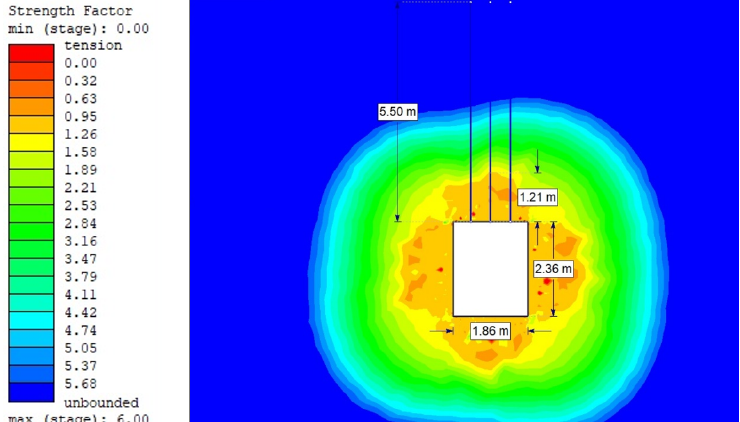
Figure 10. Strength Factor for Vernier excavation beam with full-length anchor bolting (Hoek– Brown criterion).